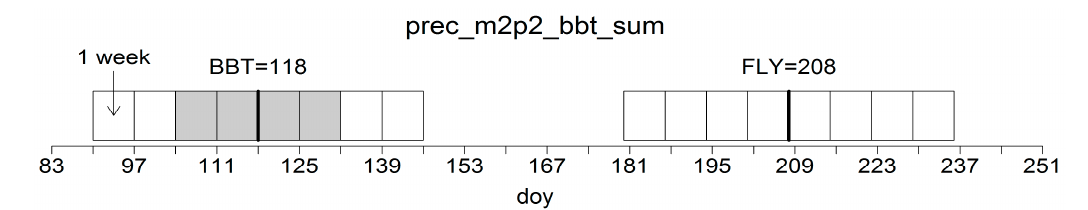
Figure 7. Construction of temporal variables of the selected climatic parameters. In this exemplary case, the acronym “prec_m2p2_bbt_sum” expresses that the variable is built by the total precipitation in the period beginning two weeks prior to and terminating two weeks after modeled BBT of P. sylvestris . The potential temporal range of variables is shown as weekly rectangles; the chosen time window is shaded in grey.